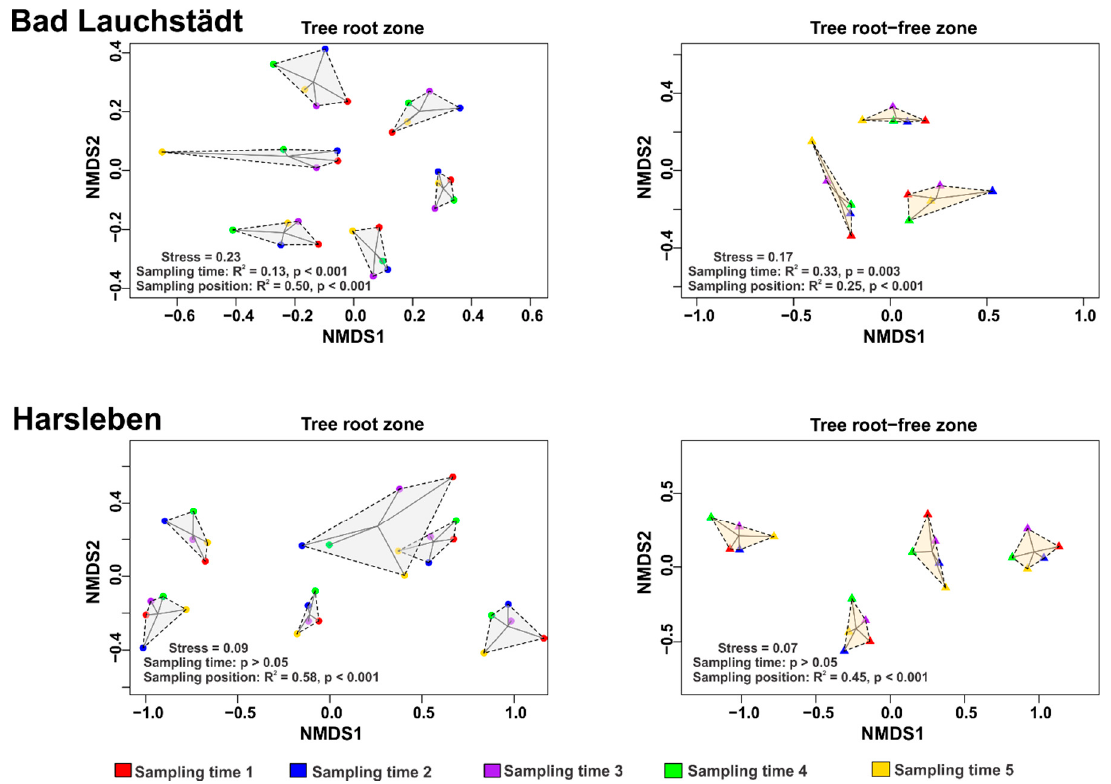
Figure 2. Non-metric multidimensional scaling (NMDS) based on Bray–Curtis dissimilarity displaying fine spatial scale partitioning of the fungal community. Sampling times coincided respectively with ends of the tree RF1, SF1, RF2, SF2, and the